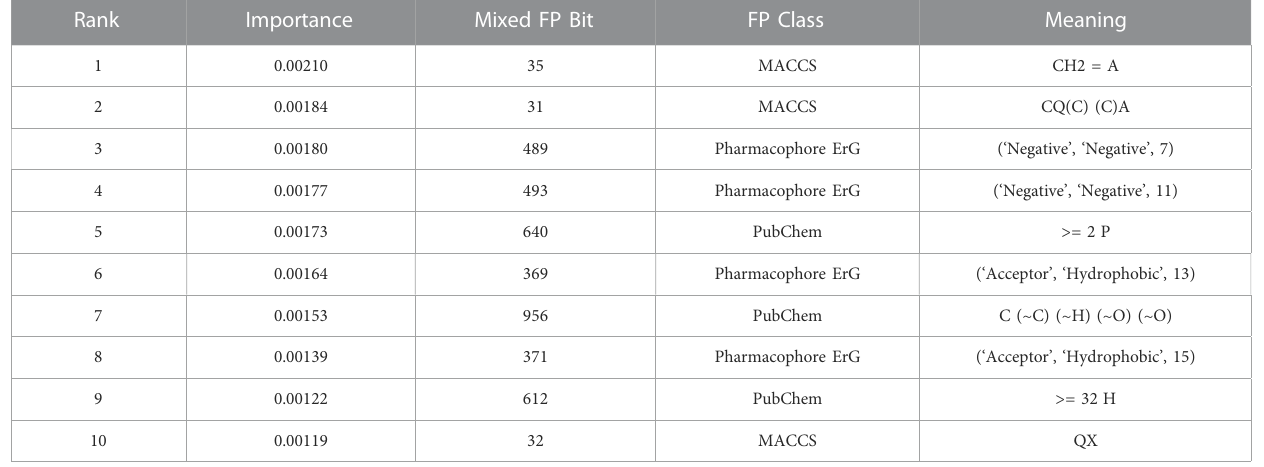
TABLE 2 The top ten signi fi cant bits from the FPN module of the multi-task FP-GNN model on the CYPs datasets. Rank Importance Mixed FP Bit FP Class